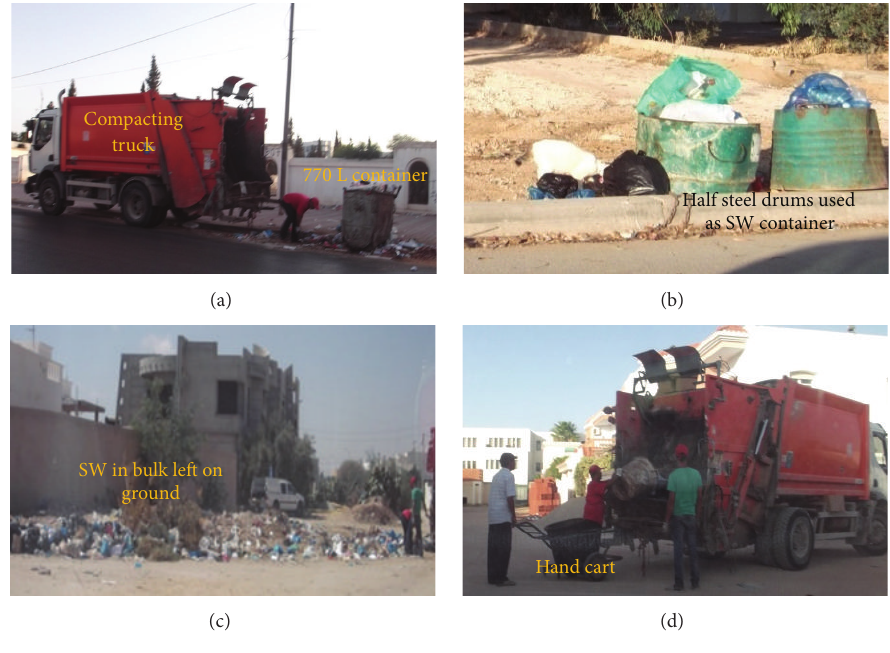
Figure 2: Conditions and equipment for waste